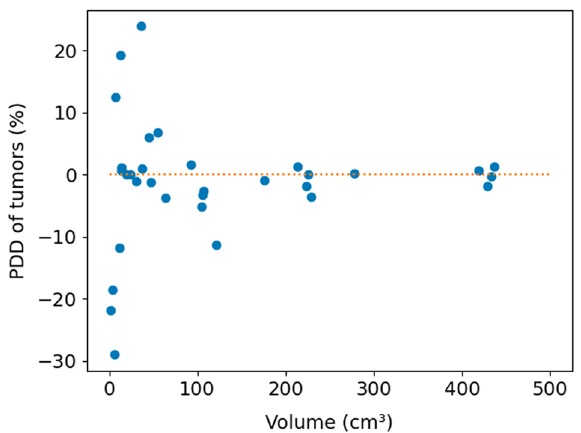
Fig. 6 Percentages of tumor dose difference between 3D and 3Dcomp reconstructions by tumor volume